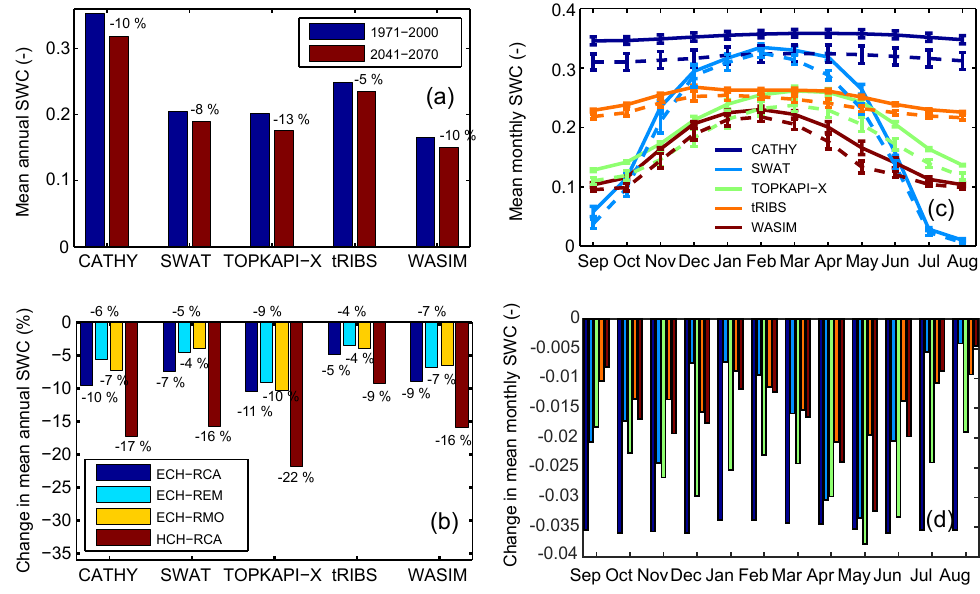
Figure 8. As Fig. 6, but for soil water content (SWC) simulated by each hydrologic model forced by the four selected climate models for the reference (REF, 1971–2000) and future (FUT, 2041–2070) periods. For panel (d) colors for each model are the same as panel (c)